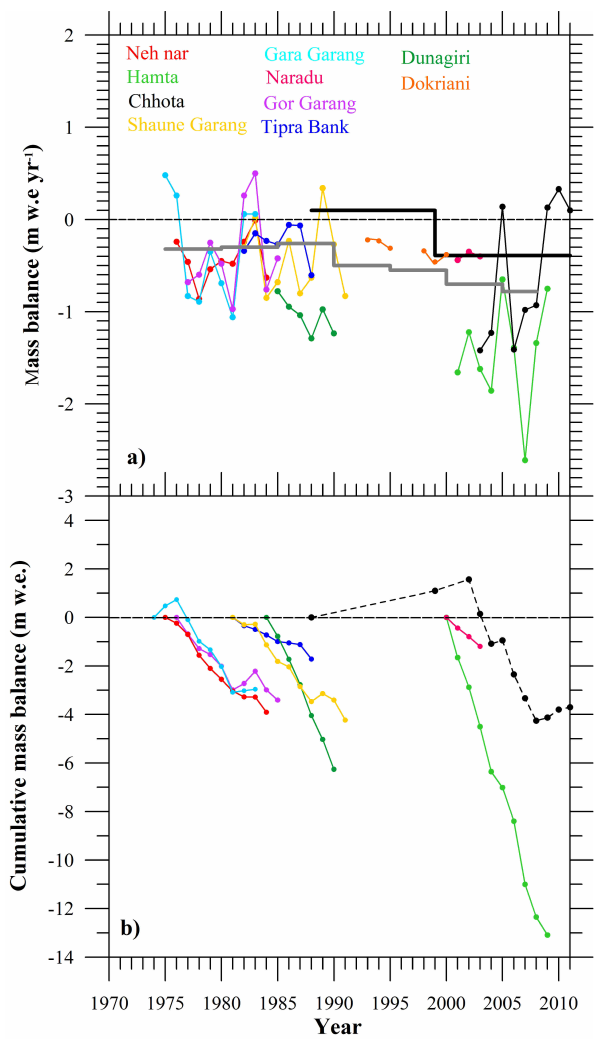
Fig. 7. MB of western Himalayan glaciers. (a) Annual glacier-wide MB of glaciers with more than one year of observations. The grey thick line corresponds to the pentadal Himalaya–Karakoram aver- ages from Cogley (2011). The black thick line comes from geodetic measurements of the Chhota Shigri Glacier, (b) cumulative